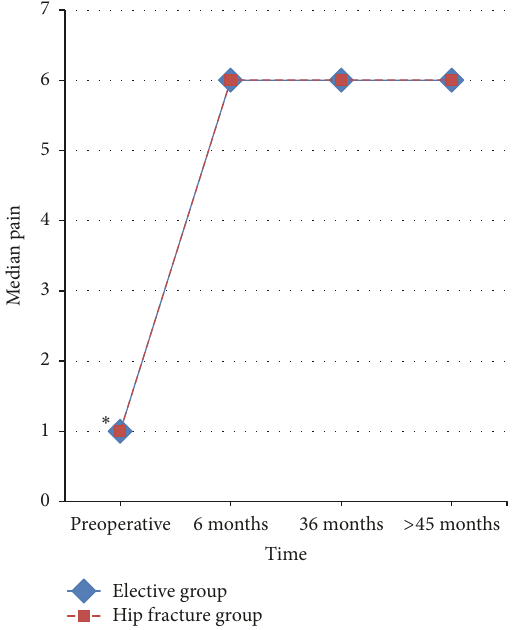
Figure 1: Line graph of Merle d’Aubign´e and Postel scores by time in the elective and hip fracture group. Comparison of the progress of the medians of Merle d’Aubign´e and Postel score during follow- up. The asterisk ( ∗ ) indicates the statistically significant difference between the compared groups.